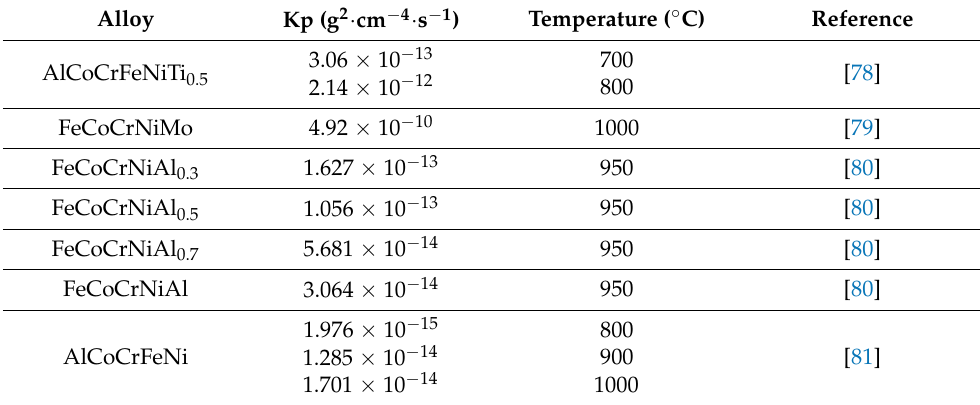
Figure 9. Oxidation kinetics of Cr 2 FeNb 0.5 Ni and Cr 2 FeNb 0.5 Ni coating at 800 °C: ( a ) Weight gains plots; ( b ) oxidation rate constant. Reprinted with permission from [77]. 2021, Elsevier. Table 3. Parabolic rate constants of HEA coatings.